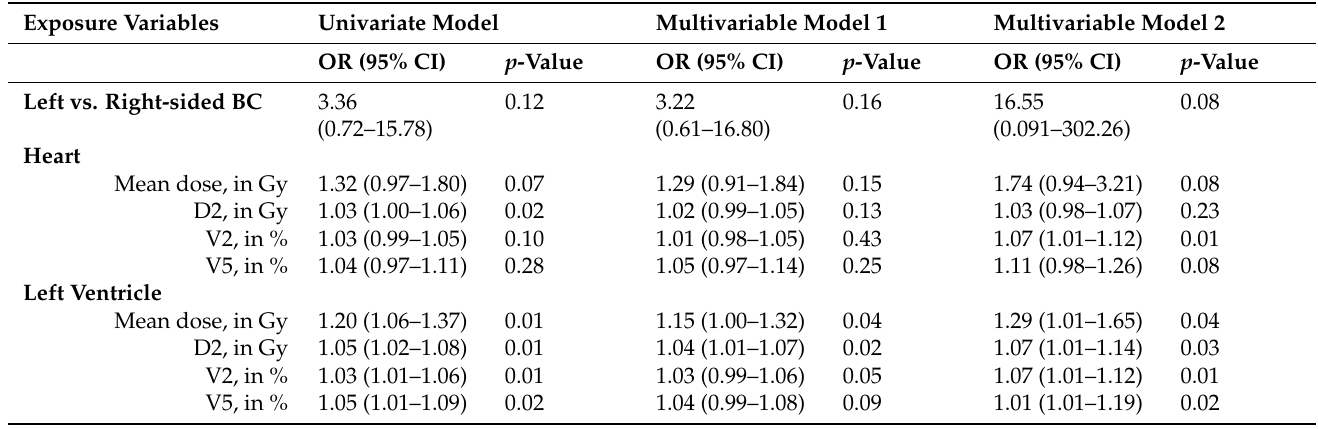
Figure 1. Comparison of cardiac doses according to the CAC progression status (0 for no CAC progression; 1 for CAC progression). LMCA: left main common coronary artery, LAD: left anterior descending artery, CX: circumflex artery; RCA: right coronary artery. The central value of the box indicates the median, the borders of the box indicate the quartiles (25th and 75th), and the extremities indicate the minimum and maximum values. p ‐ value: results of Wilcoxon test to compare dose distributions. Table 5. Association between total CAC progression (yes/no) and cardiac exposure.